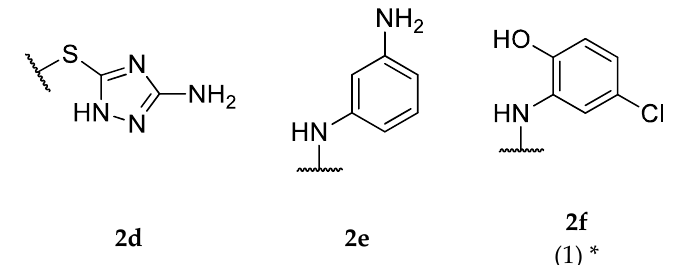
Figure 5. Structures of adenosine derivatives that belong to series 2. (* Compounds suggested by molecular docking).